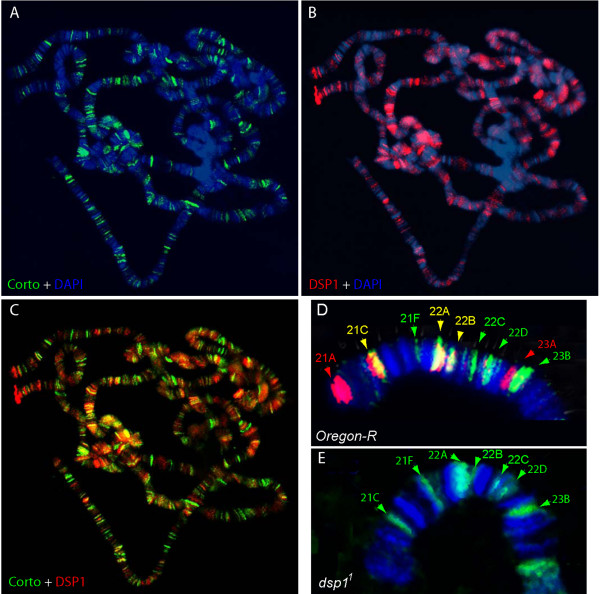
Immunofluorescence detection of Corto and DSP1 on polytene chromosomes. (A-C) Simultaneous detection of Corto (green) and DSP1 (red) on Oregon-R polytene chromosomes stained with DAPI (blue). (D, E) Magnification of chromosome 2L end of Oregon-R (D) or dsp11 (E) labeled with anti-Corto (green) and anti-DSP1 (red). Sites shared by DSP1 and Corto in Oregon-R are yellow.